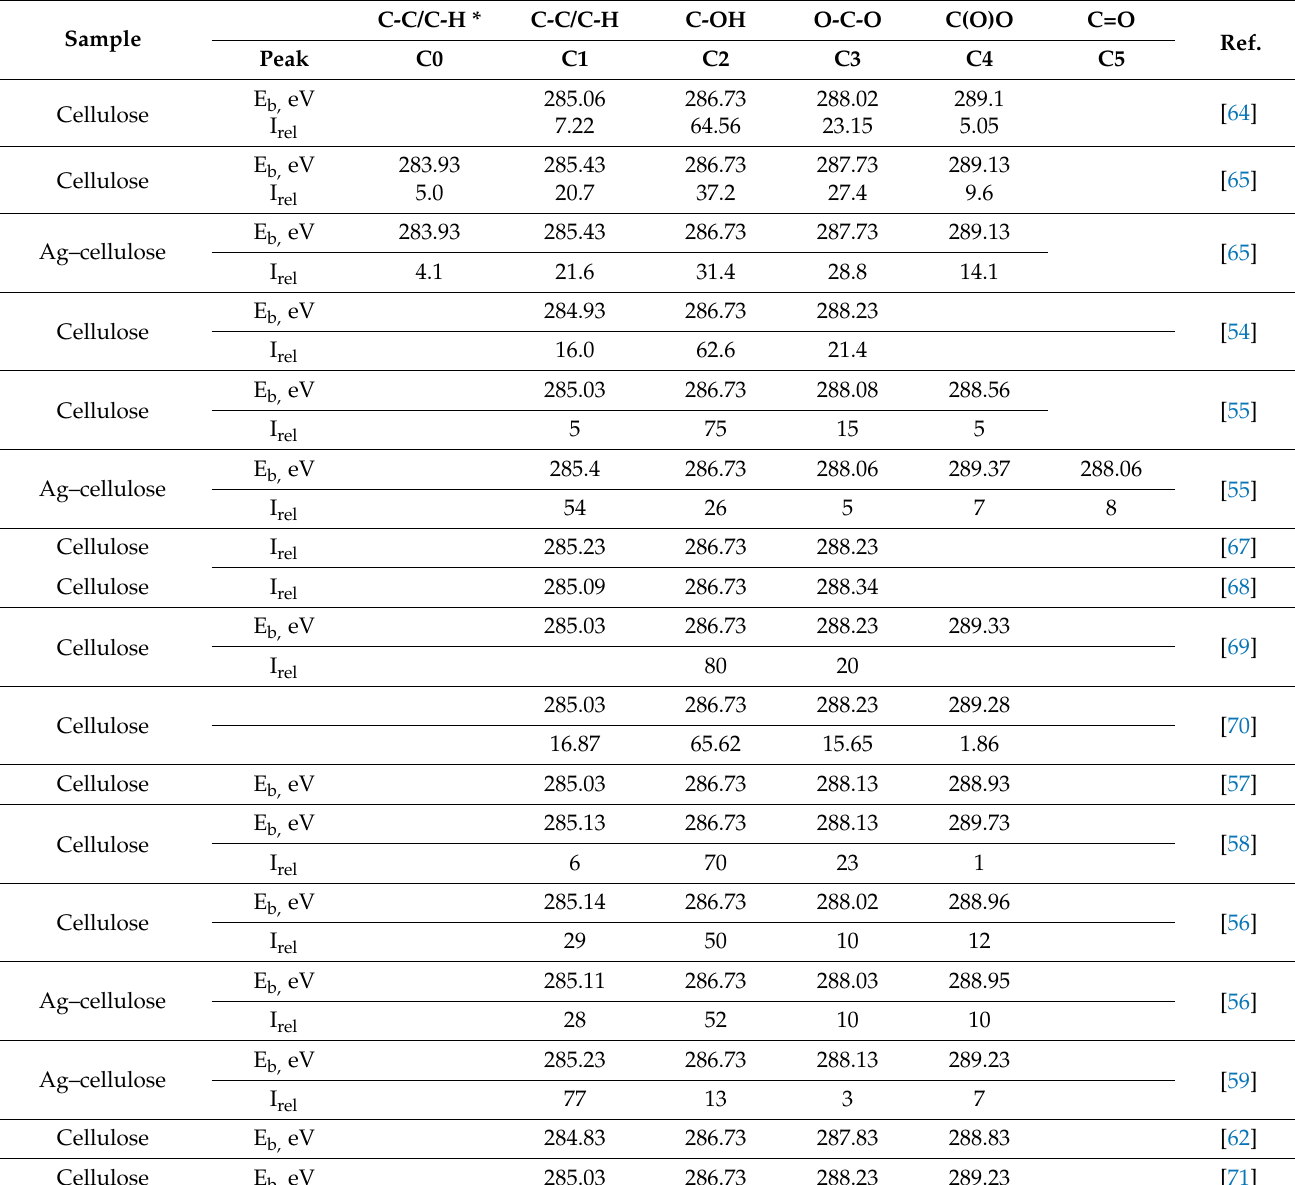
Table 1. Characteristics of the C 1s photoelectron spectra: binding energies (E b ) and relative intensities (I rel ) of photoelectron peaks assigned to different chemical